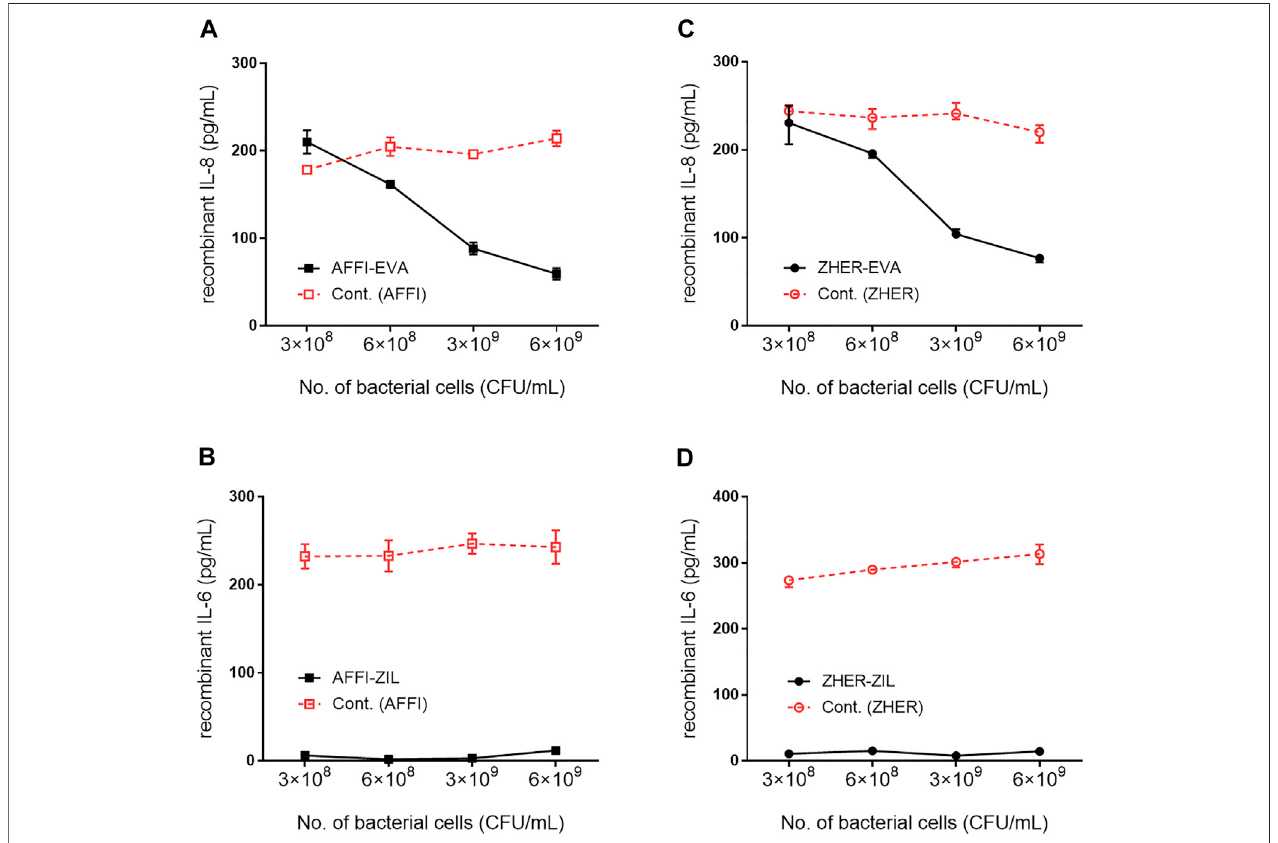
FIGURE4| RemovalofrecombinantIL-8andIL-6byengineered L.lactis asafunctionofbacterialcellnumber.TheconcentrationofrecombinantIL-8andrecombinant IL-6thatremainedinthesolutionafterincubationwithincreasingnumbersofengineered L.lactis cells,asdeterminedbyELISA.Bacterialstrainstested: L.lactis co-expressing tumorantigentargetingandcytokinebindingproteins L.lactis -AFFI-EVA (A) , L.lactis -AFFI-ZIL (B) , L.lactis -ZHER-EVA (C) ,or L.lactis -ZHER-ZIL (D) (solidline).Cont: L.lactis co-expressingtumorantigenbindersandIRFP L.lactis -AFFI-IRFPor L.lactis